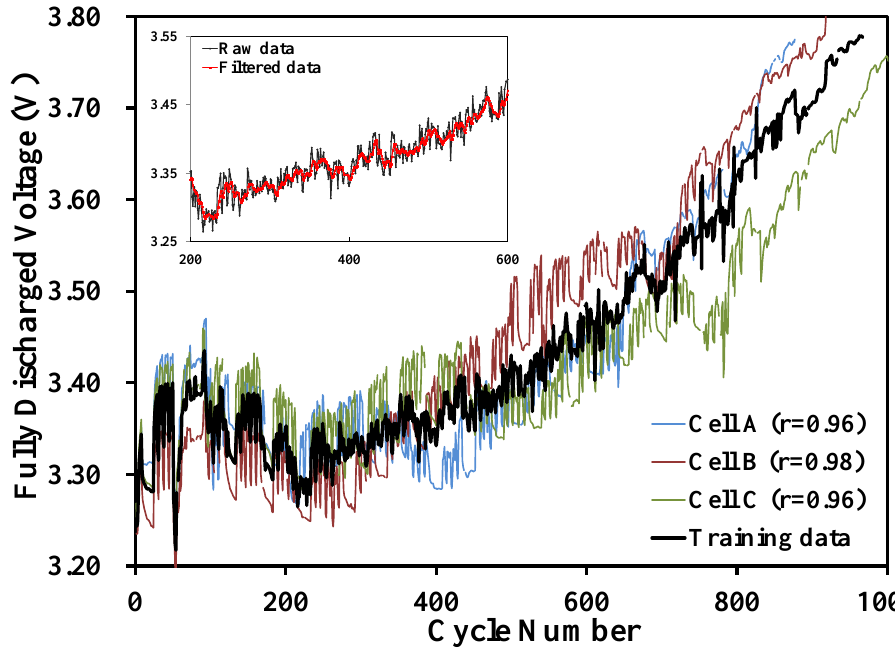
Figure 6. Illustrations of raw data, training data and filtered